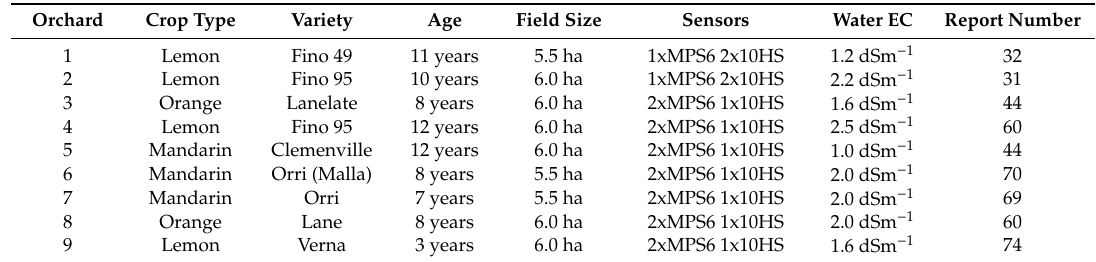
Table 1. Crops and reports used in the training process.